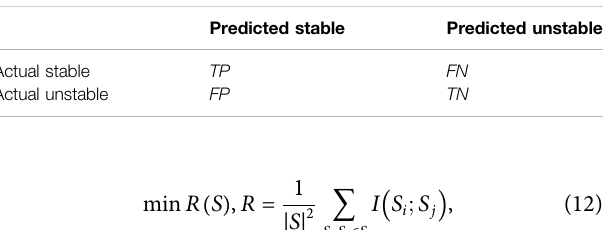
TABLE 2 | Confusion